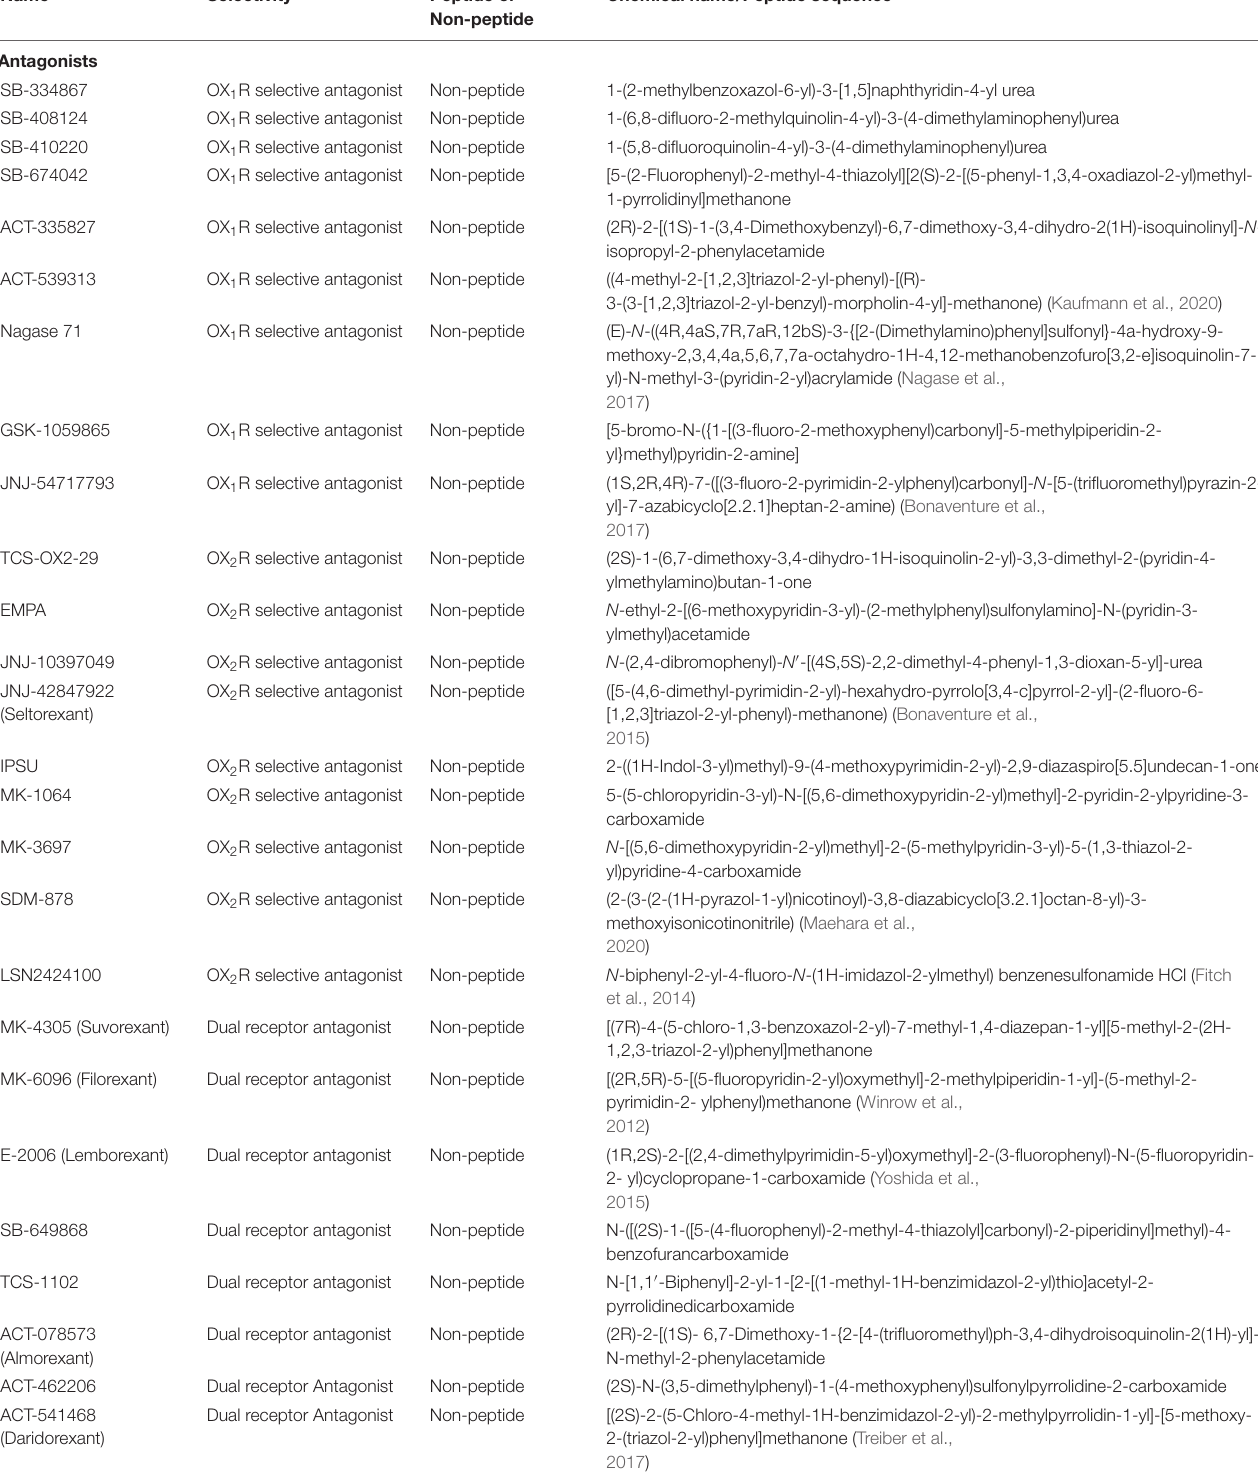
TABLE 2 | Described orexin